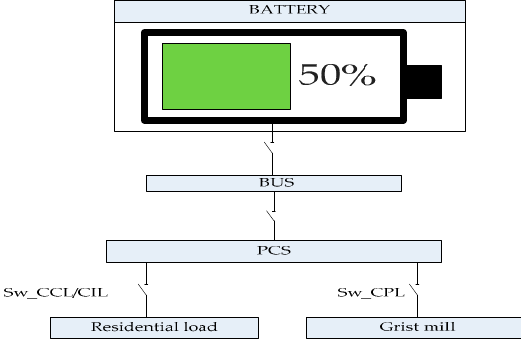
Figure 20. Demonstration of the assumed situation.